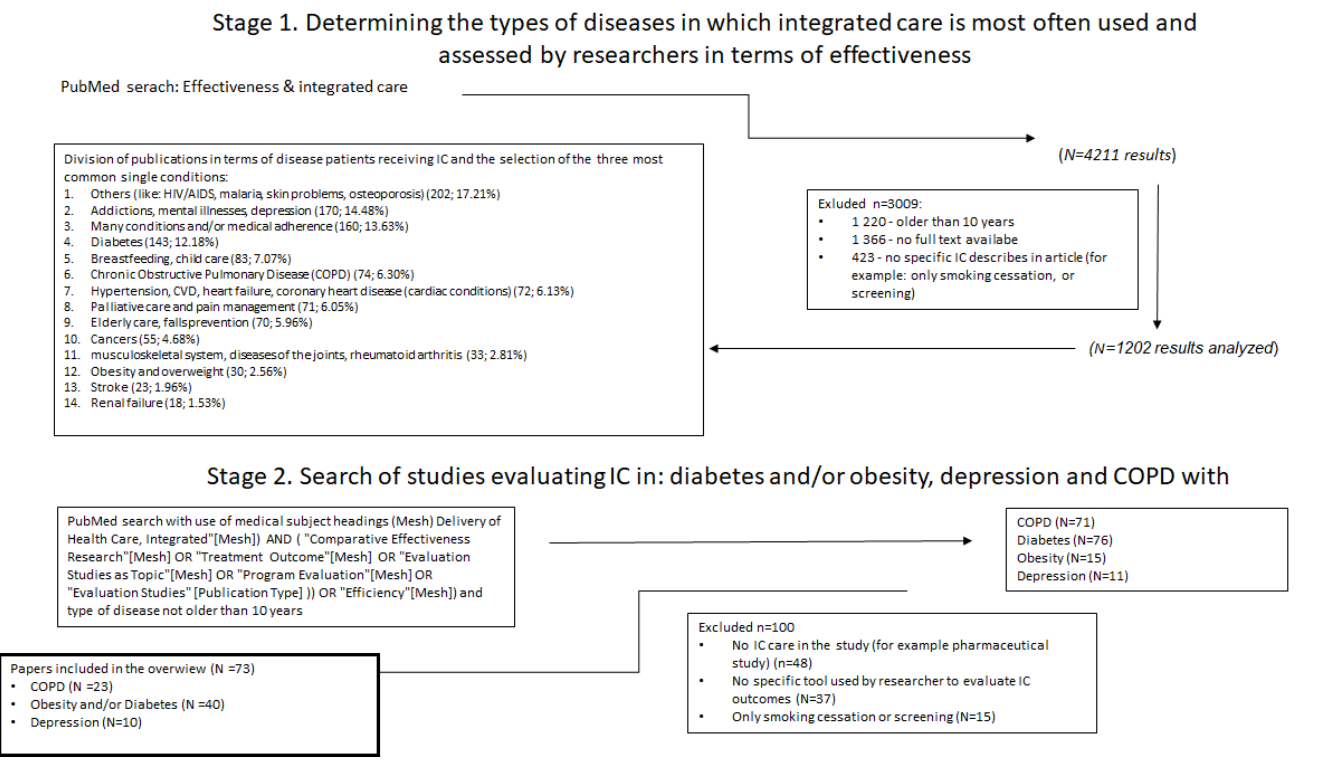
Figure 1. Search